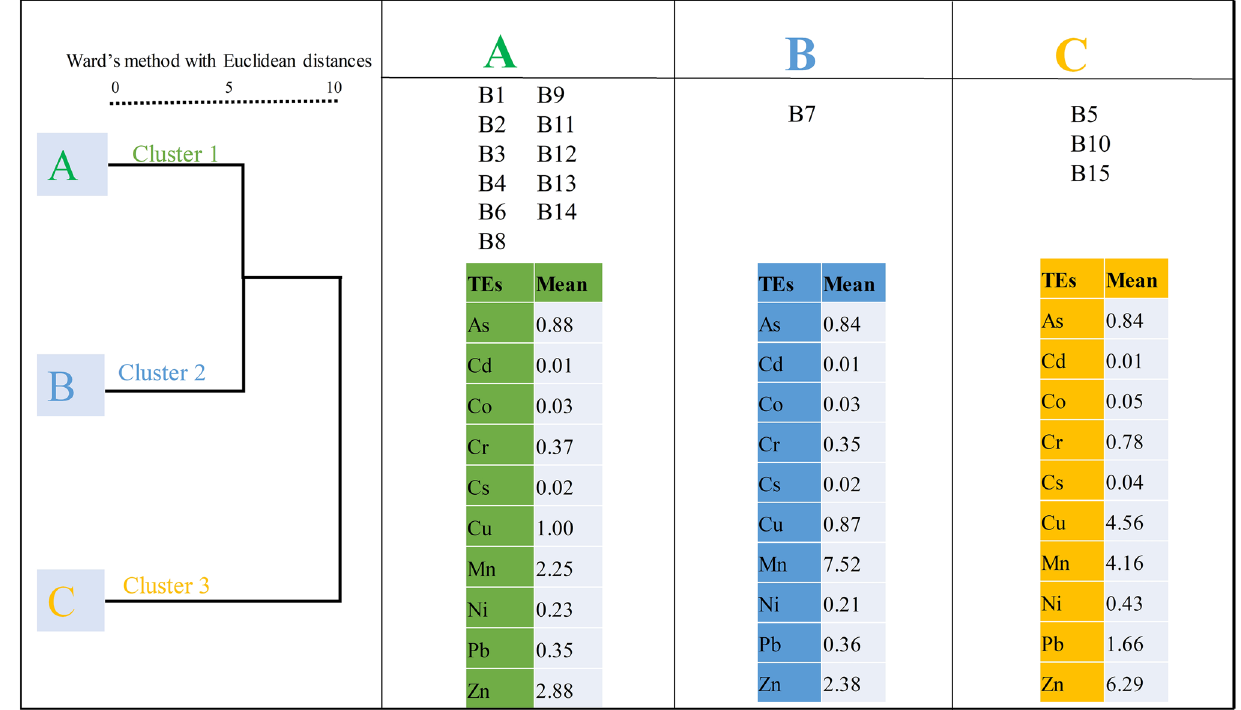
Fig. 3 Clustering of water samples in dendrogram from the Begnas Lake, Gandaki Province, Nepal (concentration of the TEs are expressed in